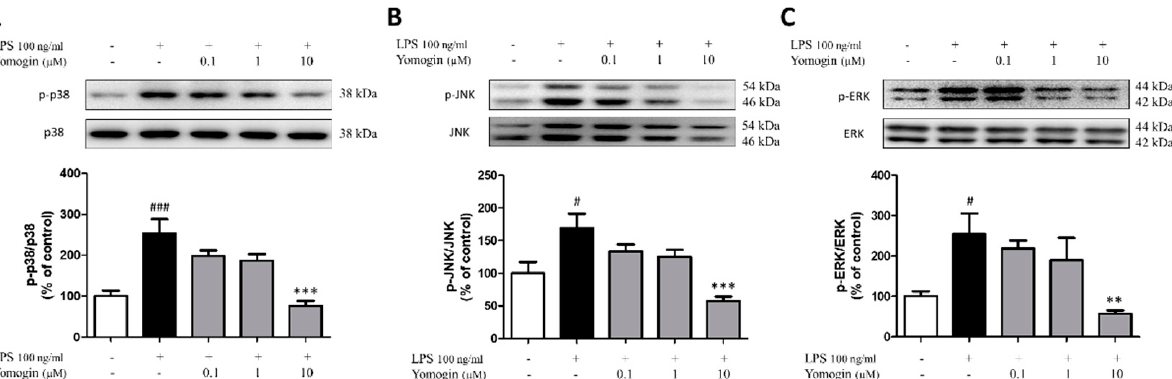
Figure 6. Effects of yomogin on MAPK signaling pathway in LPS-stimulated BV2 microglial cells. Cells were pre-treated with various concentrations (0.1–10 µ M) of yomogin for 1 h before LPS treatment. The protein levels of p-p38, p38 ( A ), p-JNK, JNK ( B ) and p-ERK, ERK ( C ) were examined by Western blot analysis ( n = 4–6 per group). Data were analyzed by one-way ANOVA, followed by Tukey’s post hoc test. # p < 0.05 and ### p < 0.001 compared to the control group; ** p < 0.01, *** p < 0.001 compared to the LPS − only − treated group. Values are the mean ± SEM.